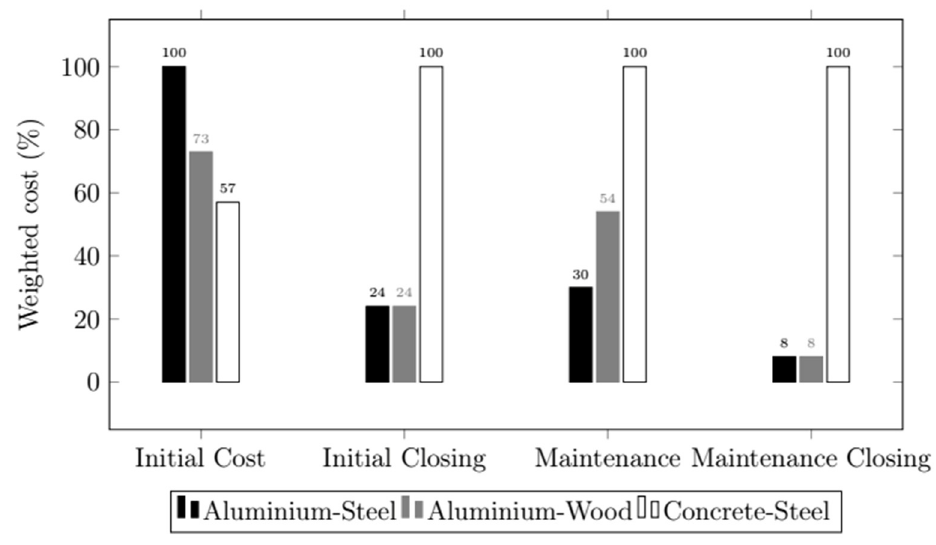
Figure 8. Breakdown of life cycle costs for alternative solutions and conventional bridges, according to spending areas.